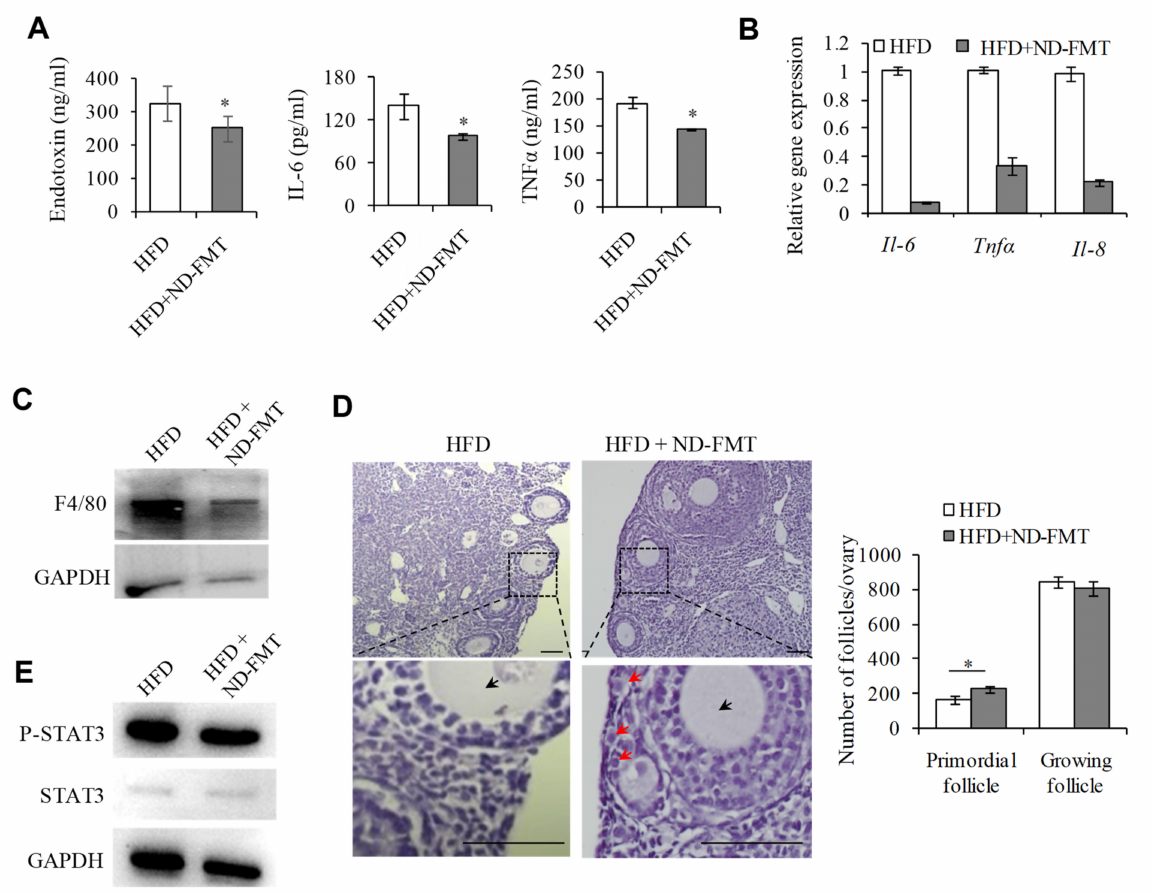
Figure 7. Transplantation of normal mice intestinal flora could rescue HFD induced overactivation of primordial follicles. ( A ) ELISIA analysis of serum concentration of LPS, TNF α , and IL-6 protein levels in HFD and HFD+ND-FMT groups ( n = 4). ( B ) The mRNA levels of Il-6, Tnf α , and Il-8 in HFD and HFD+ND-FMT mouse ovaries determined by qPCR assay. ( C ) WB analysis of the protein levels F4/80 in HFD and HFD+ND-FMT mouse ovaries. GAPDH used as a loading control. ( D ) Representative H&E staining images and follicle number counts in HFD and HFD+ND-FMT mice ( n = 5). Red arrows represent primordial follicles. Black arrows represent growing follicles. Scale bar = 100 µ m.* p < 0.05. ( E ). WB analysis of the protein levels of p-STAT3, STAT3, and GAPDH in HFD and HFD+ND-FMT mouse ovaries. ( F ) Proposed model for intestinal flora changes induced by a HFD exacerbating activation of primordial follicles through macrophage infiltration and inflammatory factor secretion in mouse